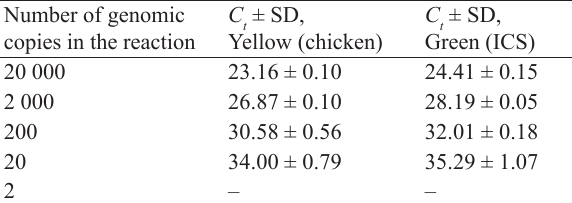
Table 3 Sensitivity of the duplex PCR system (initial concentration of plasmid DNA – 4 ng/μL) Number of genomic copies in the reaction